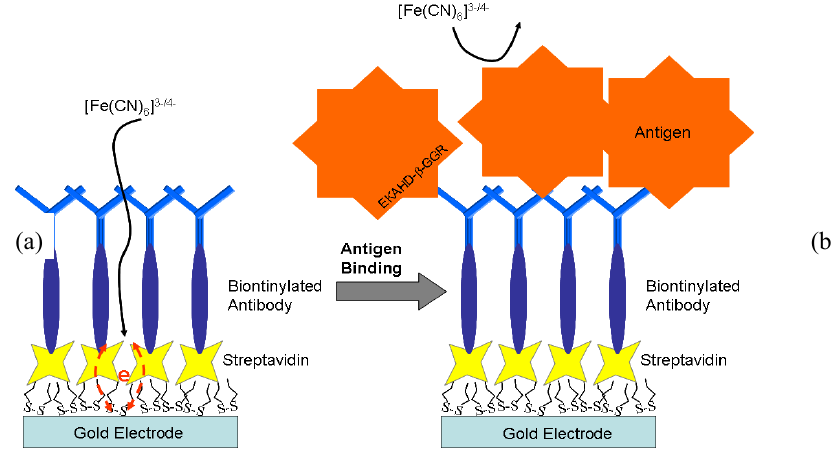
Figure 7. Schematic representation of a label-free immunosensor for bone turnover maker detection. Part (a) shows a self-assembled monolayer of dithiodipropionic acid deposited on a gold surface with streptavidin immobilized next as a self-assembled monolayer. Then the biotinylated antibody was bound to the streptavidin. Part (b) illustrates the antigen- antibody binding event and how it hinders the interfacial electron transfer reaction of [Fe(CN) ] 3–/4– . 6